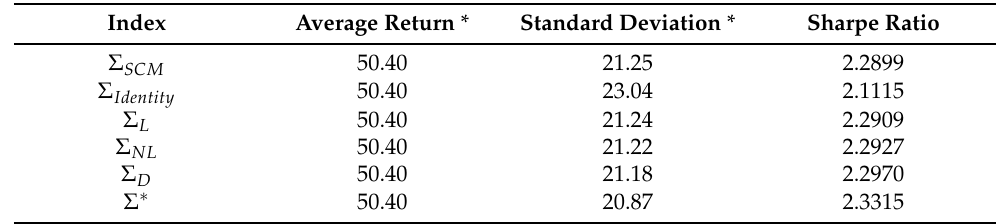
Table 8. The out-of-sample performance comparison between each estimations of the 426 assets in CSI500.